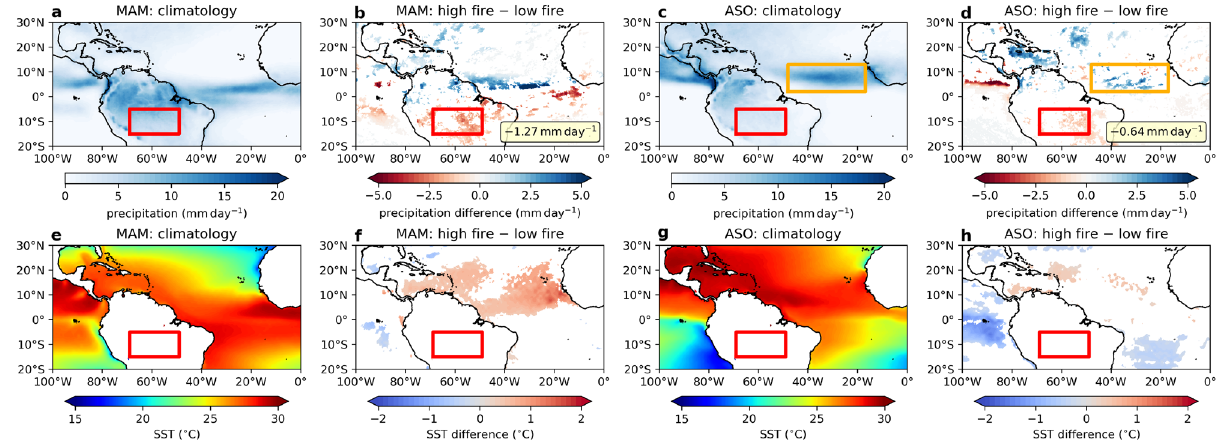
Figure 3. Precipitation and SST climatology and anomalies. ( a ), ( c ): Climatology of ( a ) MAM and ( c ) ASO precipitation between 2001 and 2018. ( b ), ( d ): Same as ( a ) and ( c ) except for composite difference (significant at 95% confidence interval) of the top and bottom 5 years between 2001 and 2018 ranked by ASO Amazon fire count. Average precipitation difference over the Amazon is given in the lower right. ( e ), ( g ): Same as ( a ) and ( c ) except for SST. ( f ), ( h ): Same as ( b ) and ( d ) except for SST. ( a )–( h ): The red box is the Amazon fire region. ( c )– ( d ): The orange box includes the Atlantic